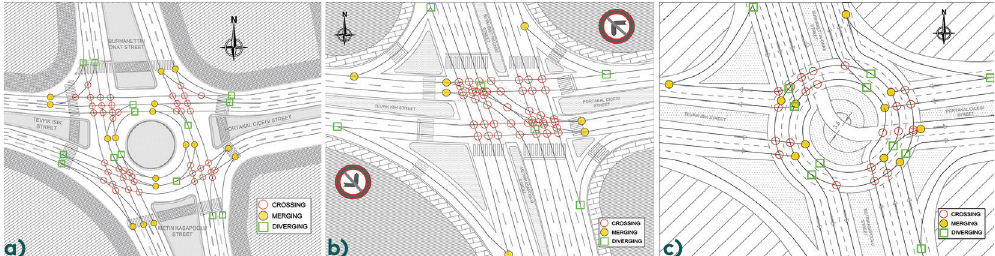
Figure 26. Conflict points for the roundabout: a) the status for 2016; b) the current status; c) the status for the proposed type (by Y. User & S.